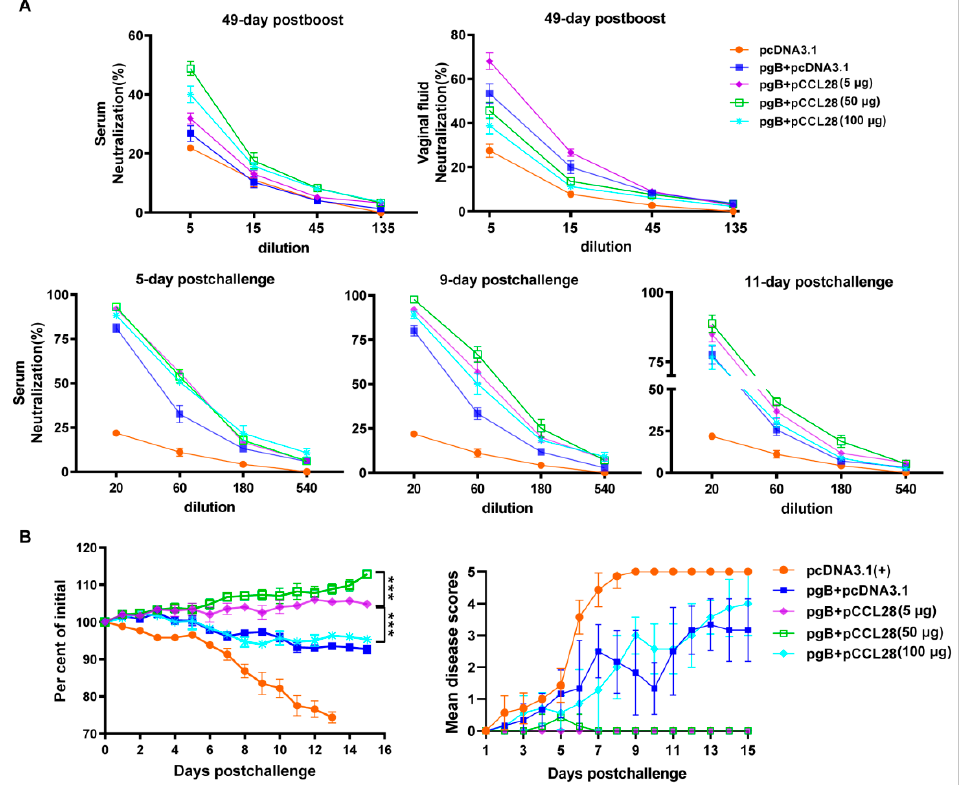
Figure 2. Neutralizing activities of murine sera and vaginal fluids and the protective effects on immunized mice against vaginal HSV-2 challenge. ( A ) Neutralizing activities of murine sera and vaginal fluids. Sera of immunized mice ( n = 5/group) were collected on the indicated days, and the neutralizing activities were tested at a starting dilution of 1:5 (on day 49 post boost) or 1:20 (on days 5, 9, and 11 post challenge). Vaginal fluids of immunized mice ( n = 5/group) were collected on day 49 post boost, and the neutralizing activities were tested at a starting dilution of 1:5. The CPE index was evaluated within 36–48 h, and the percentages of the inhibition curves were plotted. ( B ) Weight loss ( left panel ) and disease severity ( right panel ) were monitored up to 15 days post challenge. Data are expressed as the means ± SEMs pooled from at least three independent experiments, with each condition performed in duplicate. *** p < 0.001; pgB + pCCL28 (5 µ g) compared to pgB + pCCL28 (50 or 100 µ g) group by Kruskal–Wallis nonparametric analysis of variance